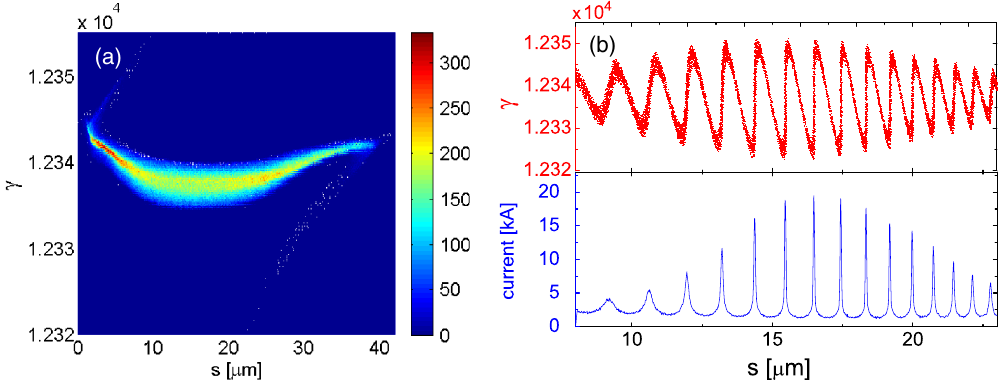
FIG. 2. (a) Longitudinal phase space at the end of the linac. (b) Longitudinal phase space and the corresponding current distribution at the end of the ESASE section. The bunch head is to the